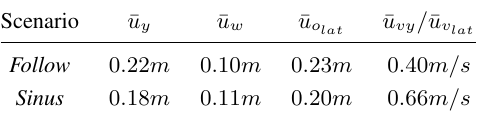
Table 4: Derived uncertainties for the scenarios.